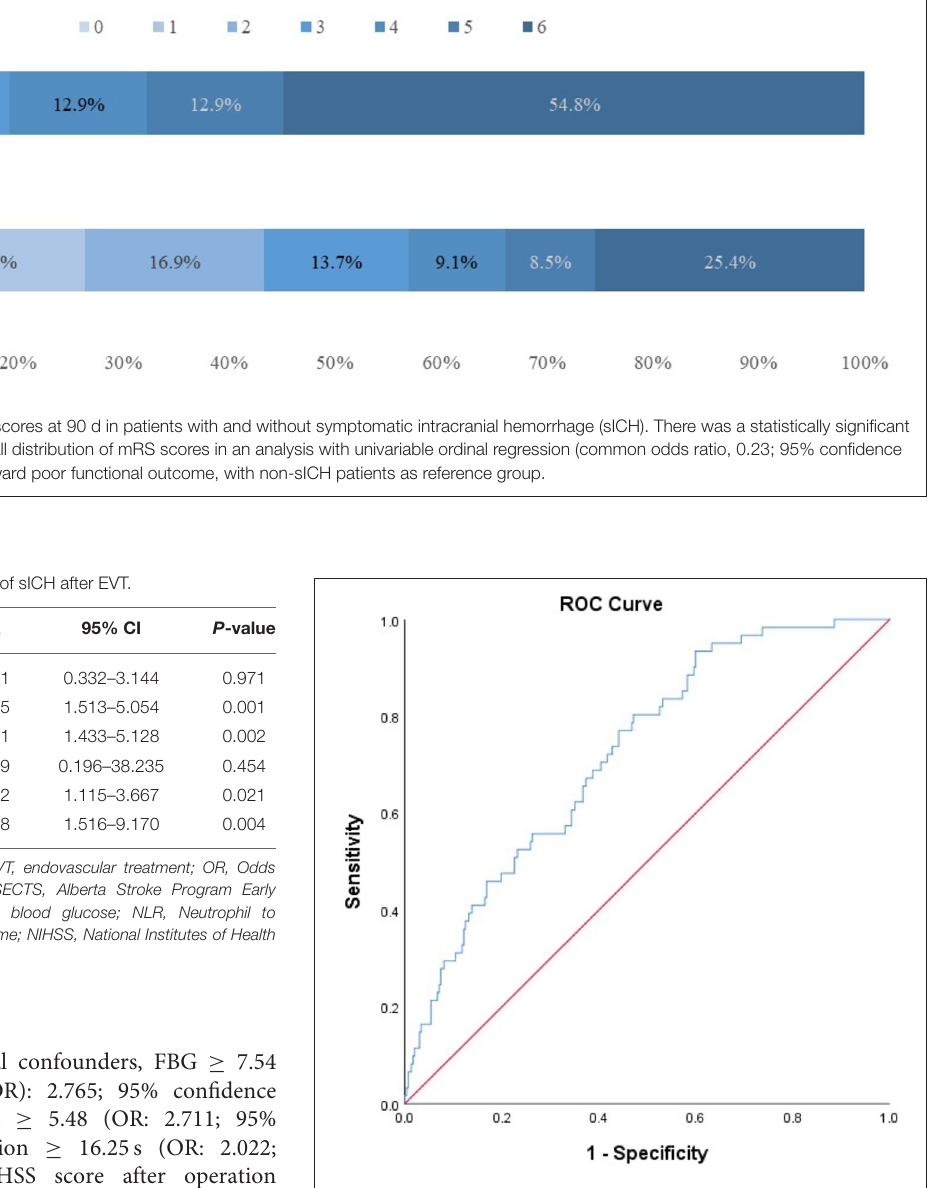
FIGURE 3 | Receiver operating characteristic (ROC) curve for the value of model to predict sICH. The ROC curves showing the predictive ability of the model (including ASPECTS score at admission, NIHSS score after operation, FBG, NLR, PLT, and TT levels). Area under the curve of the model: